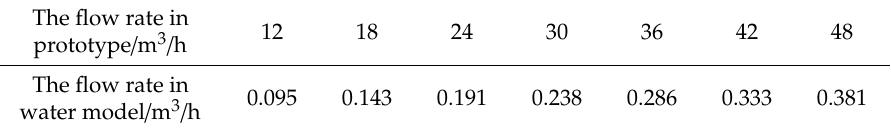
Table 2. The flow rate of bottom gas in the water model and prototype ladle.